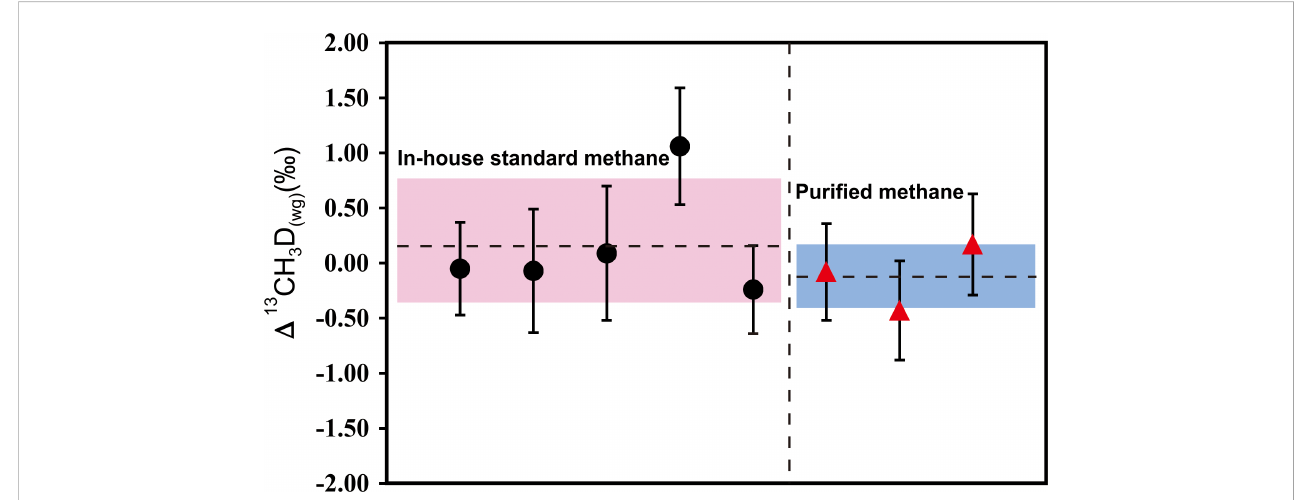
FIGURE 11 D 13 CH 3 D (wg) of in-house standard methane versus puri the average of the measured data with pink area and blue area marking 2SD.